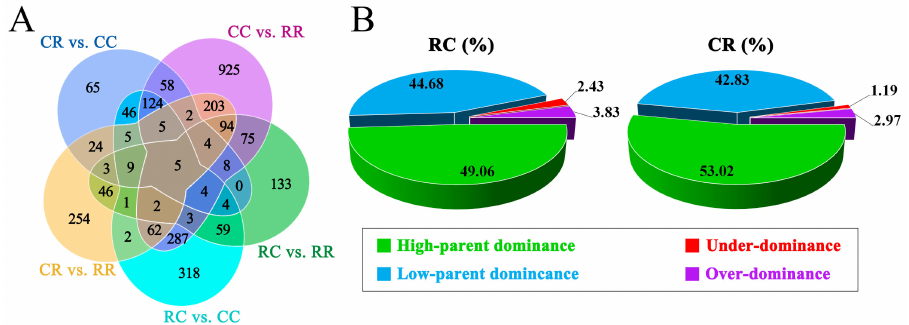
Figure 2. Analysis of gene expression patterns. ( A ) The number of di ff erentially expressed genes (DEGs) among F1 progenies, and ( B ) the proportions of high- / low-parent dominant and over- / under-dominant genes in non-additive genes.